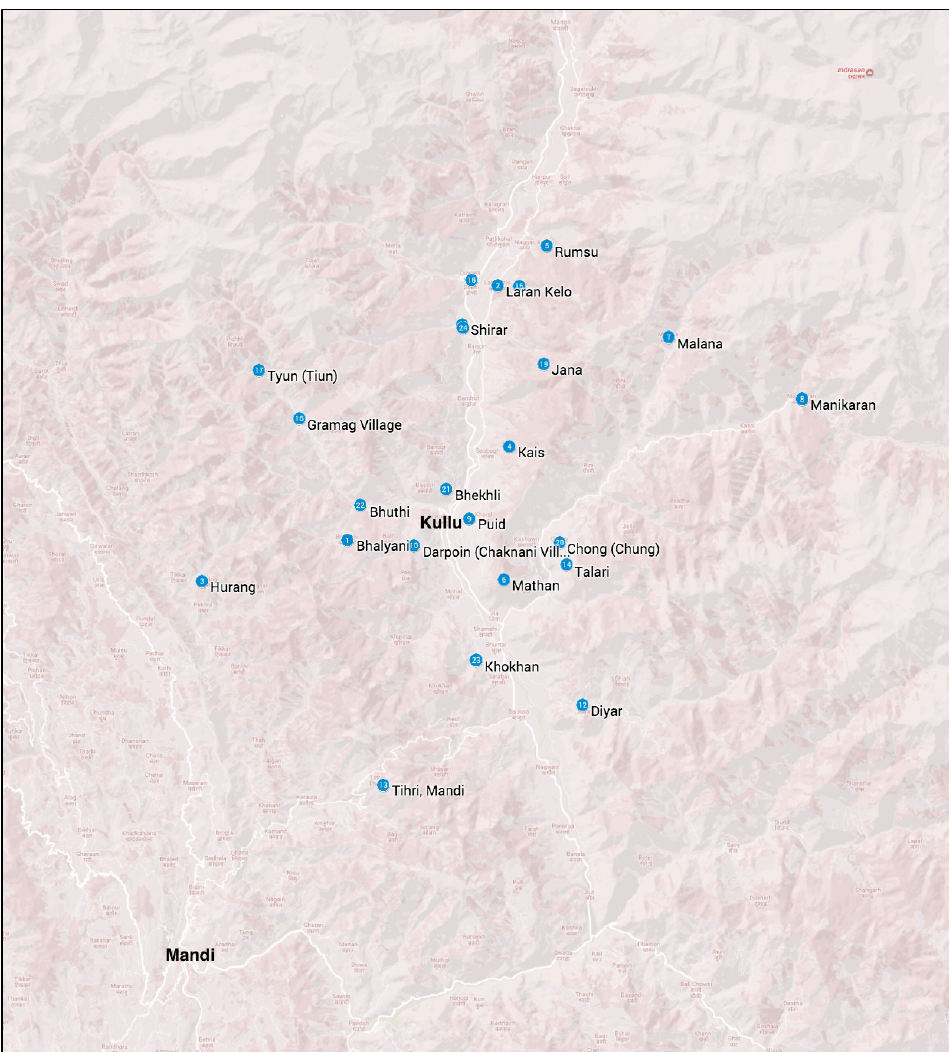
Figure 1. Map of places where Kahika is celebrated (central Himachal Pradesh, India).